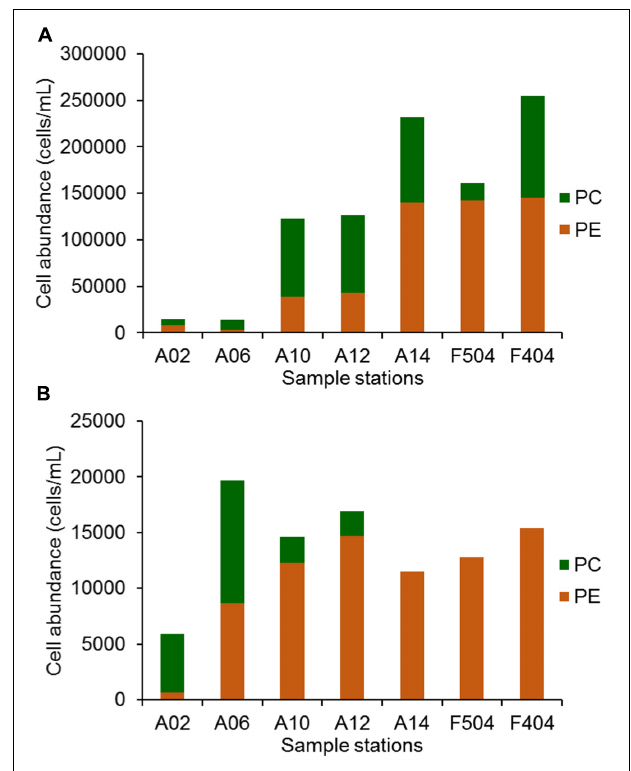
FIGURE 2 | The abundance of PC only and PE containing Synechococcus in the surface (A) and bottom (B) of sampling stations.